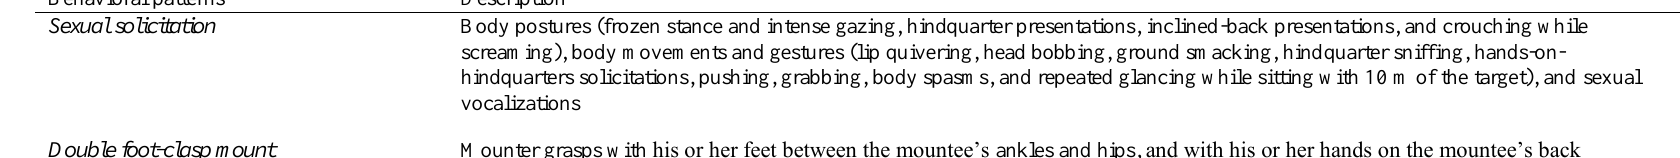
Social and Sexual Behavioral Patterns Collected During the Study Behavioral patterns